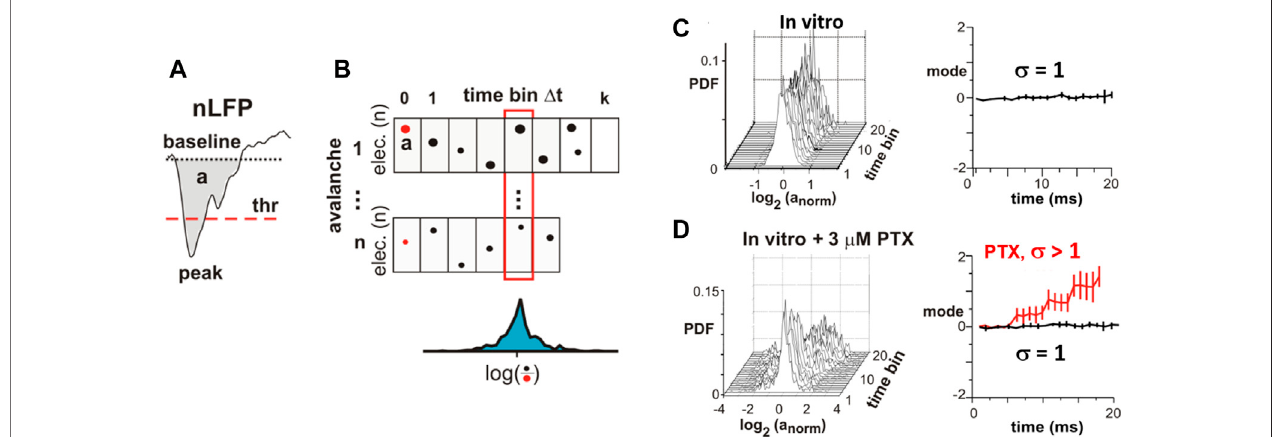
FIGURE 7 | Critical branching parameter estimation for coherence potentials. (A) Area a and waveform of a local nLFP identi fi ed by threshold ( thr ) crossing. (B) nLFP areasnormalized bythe initial nLFP area( red dots ) distributearound a median value ( blue distribution ) after n time bins of duration Δ t . (C) In vitro avalanches reveal distribution around the log(1) (cid:2) 0 mode demonstrating that, as an avalanche unfolds, nLFPs on average neither grow nor decay in the area in line with expectations for a criticalbranching process with σ (cid:2) 1. (D) Inorganotypiccortex cultures thataremade moreexcitablebyslightlyreducinginhibition ( PTX ),an expansion ofthe nLFP area with time from cascade initiation is found in line with the prediction for a supercritical branching process with σ > 1. These experiments demonstrate that atransition from a power law in sizes to a bimodal size distribution under reduced inhibition changes the system from critical to supercritical dynamics (reproduced with permission from